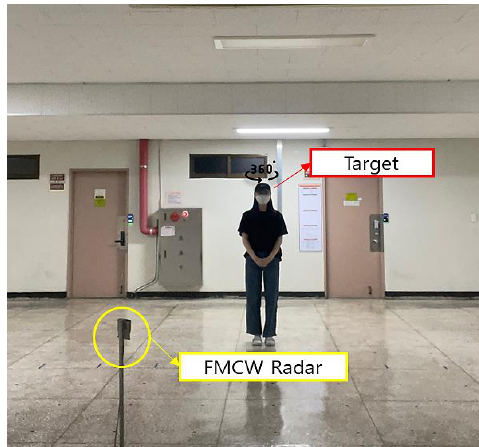
Figure 2. Schematic of experimental configuration with one FMCW radar and target.